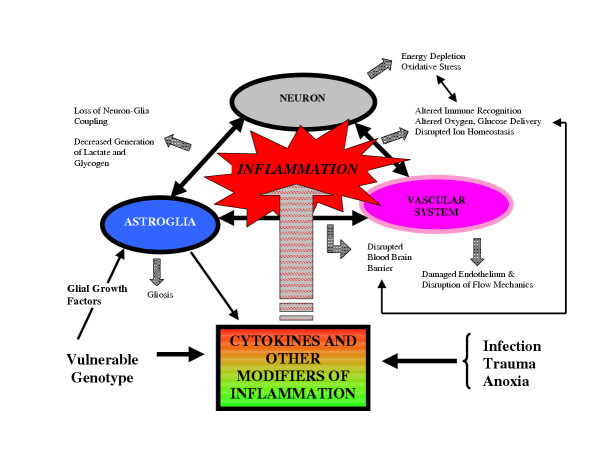
Simplified schematic illustrating the interconnected vascular-glial-neuron triad and how inflammatory processes may disrupt normal function.